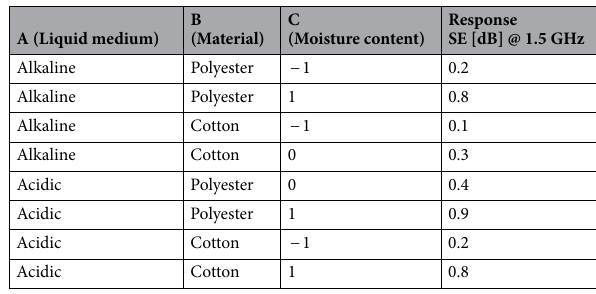
Table 4. The factors and their mean shielding effectiveness at 1.5 GHz.